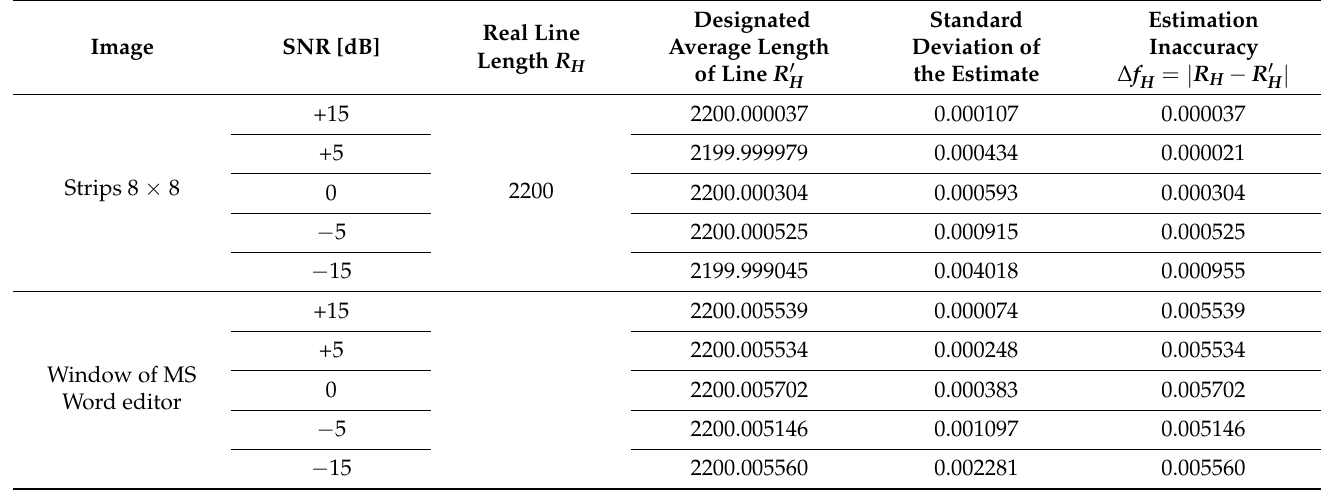
Table 7. Average values of the R H parameter determined by the CZT method for synthetic signals (strips 8 × 8, window of MS Word editor).